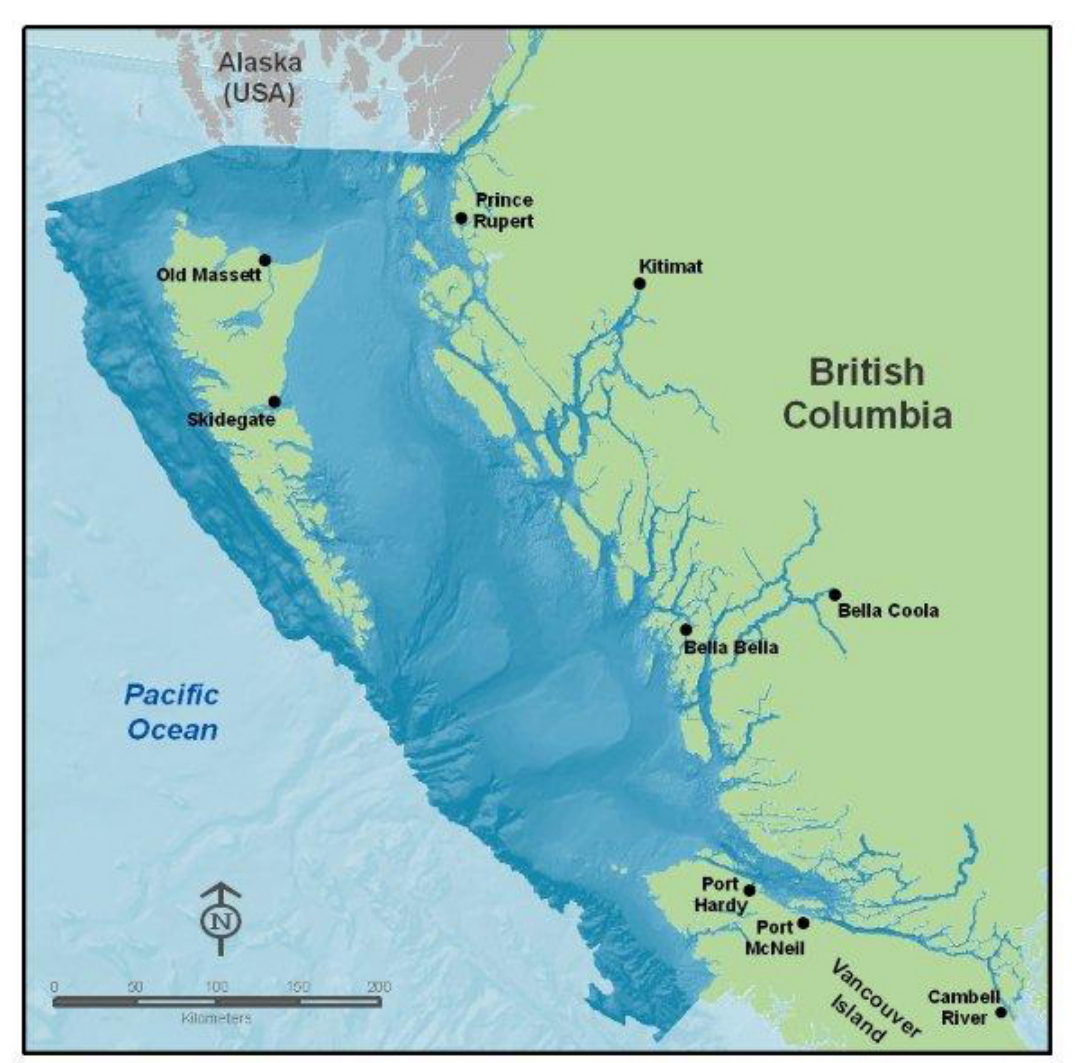
Fig. 2 . Location of Pacific North Coast Integrated Management